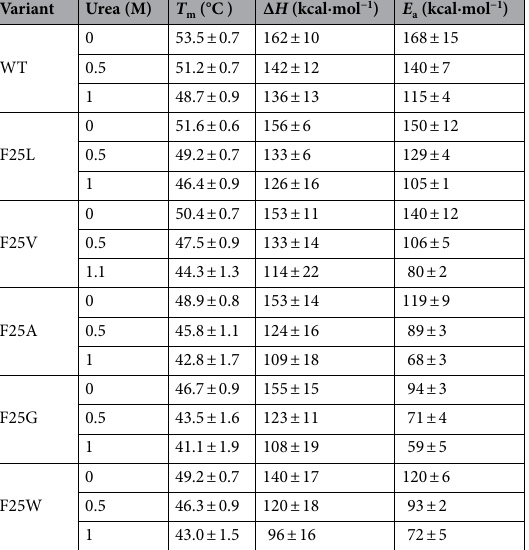
Table 2. Energetic parameters for the denaturation of hPGK1 variants determined from DSC data in the absence or the presence of urea. Data are the mean ± s.d. for three different scan rates (4, 2.5 and 1 °C min −1 ) at 7–15 µM protein concentration and using a two-state irreversible model.